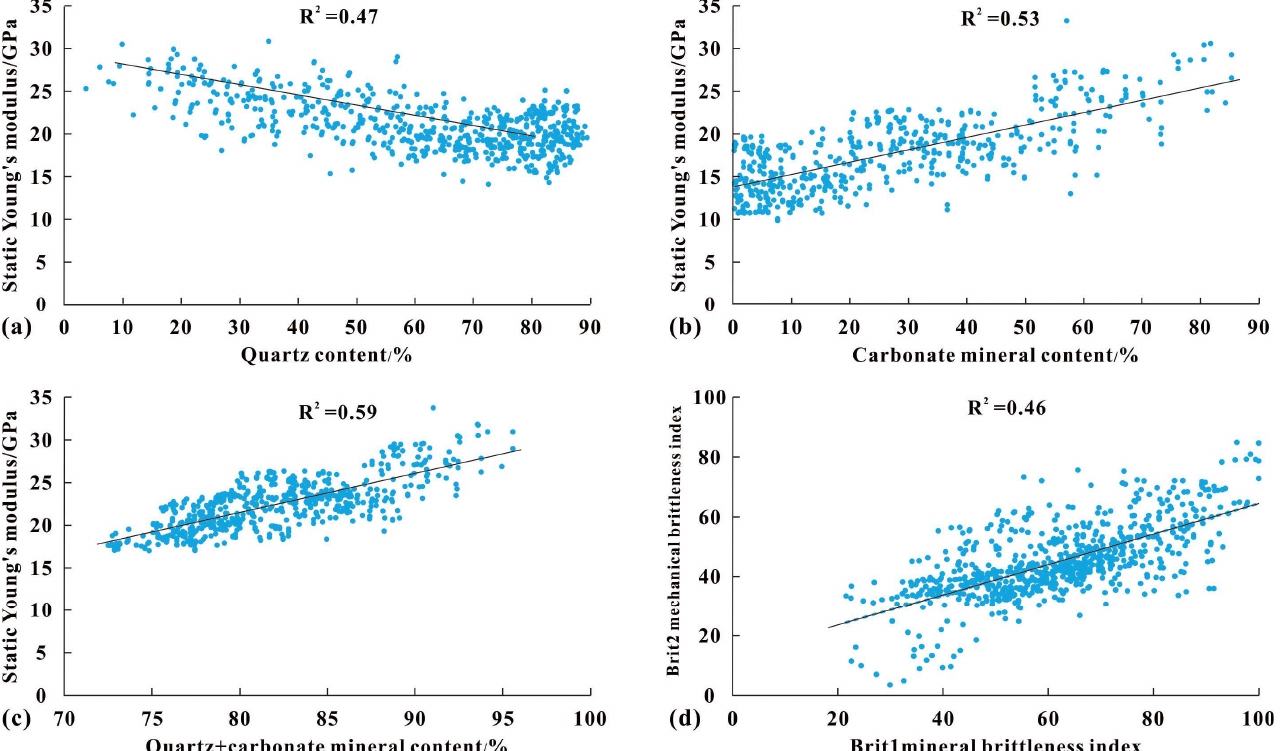
Figure 8. Relationship between rock mineral composition and mechanical parameters. ( a ) Relation- ship between quartz content and Young’s modulus. ( b ) Relationship between carbonate content and Young’s modulus. ( c ) Relationship between quartz + carbonate content and Young’s modulus. ( d ) Relationship between mineral brittleness index and mechanical brittleness